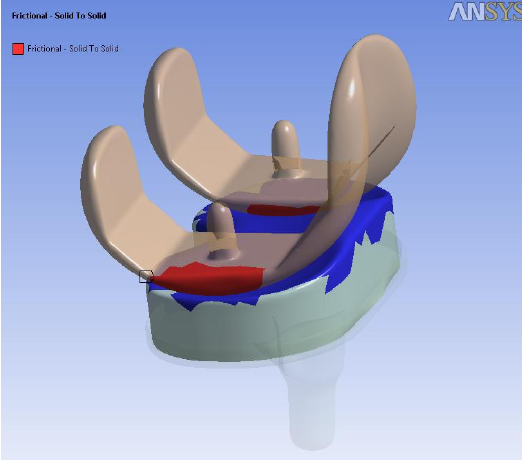
Figura 7: Definizione delle aree di contatto fra componente femorale e inserto in UHMWPE. Figure 7: Contact area between the femoral component and the UHMWPE insert.